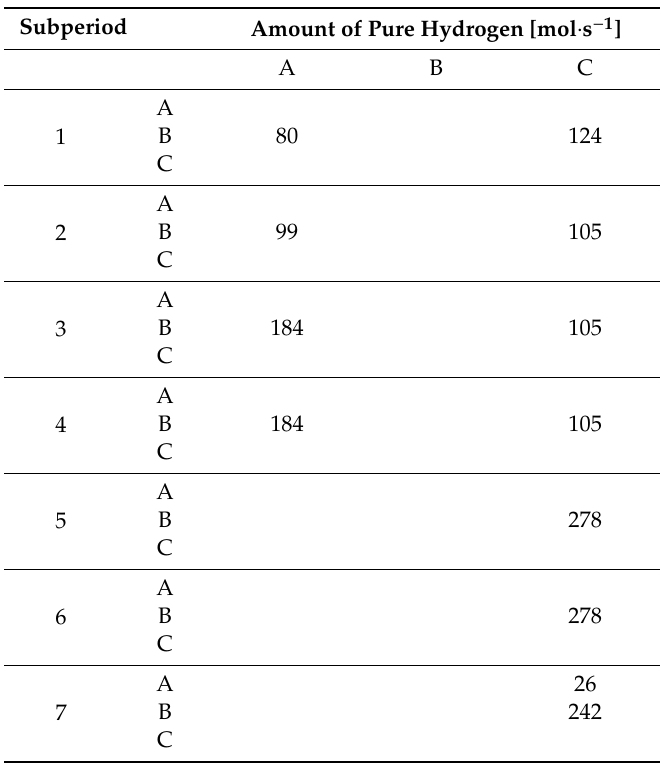
Table 7. The amount of hydrogen exchange among the plants in the structure-merged method.